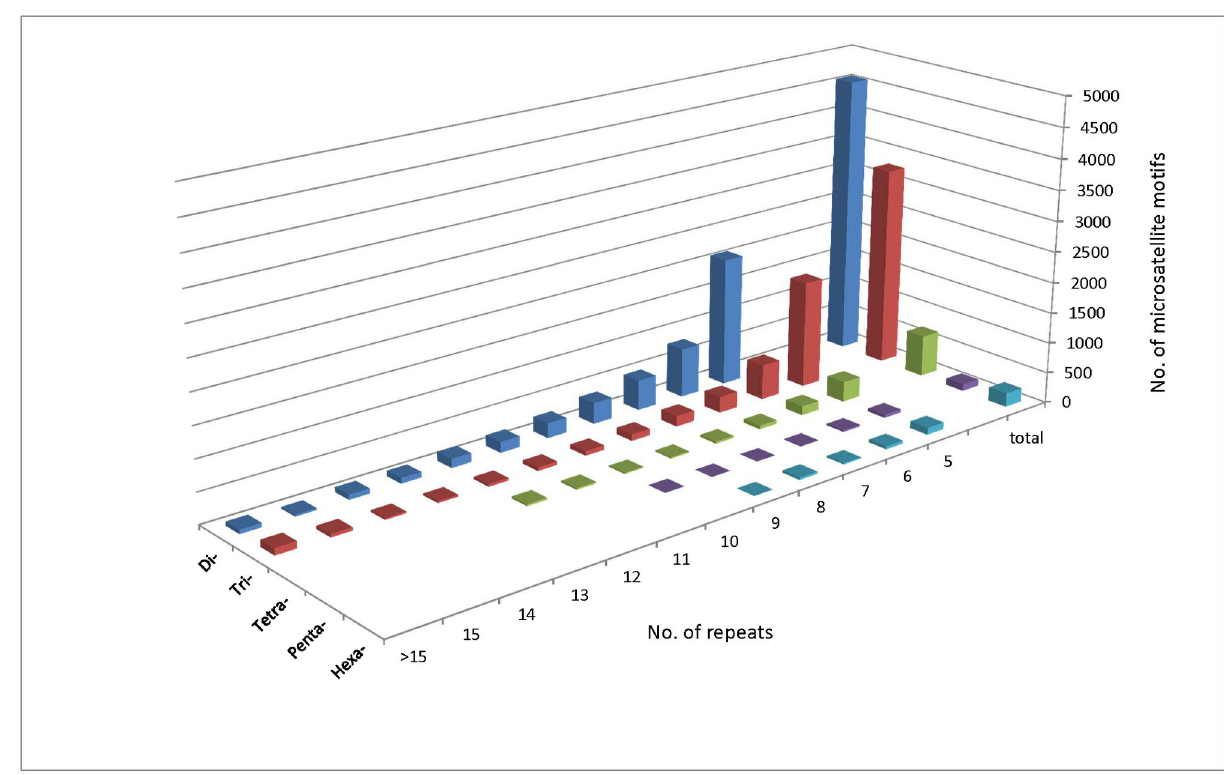
Figure 3. Distribution of Di- to Hexa- microsatellite motifs in Anisogramma anomala by number of repeats. doi: